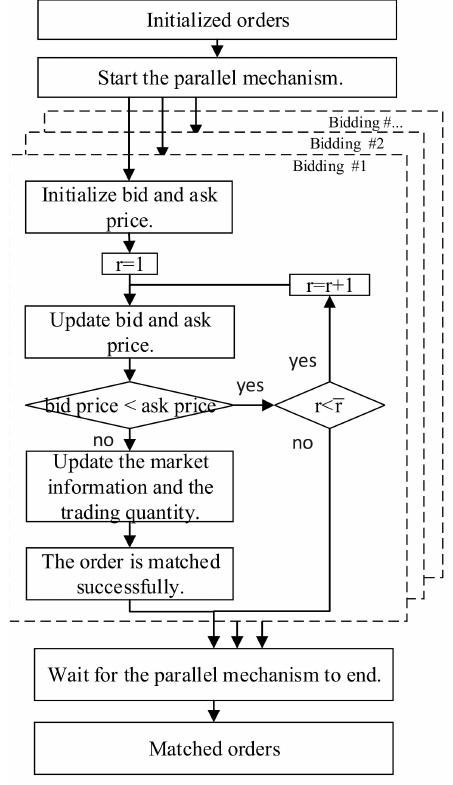
Figure 4. Price bidding for P2P order